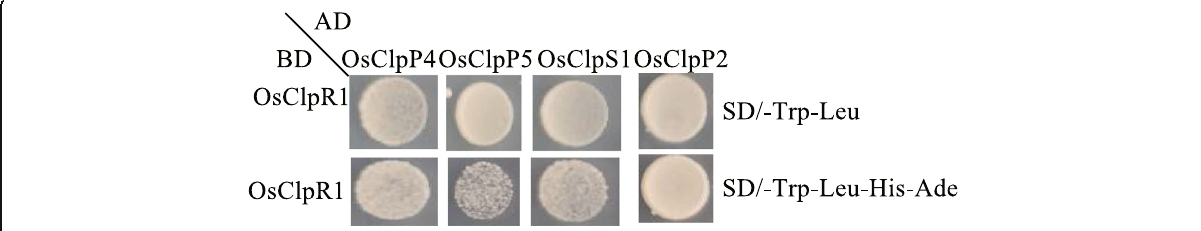
Fig. 7 Interaction between OsClpR1 and OsClpP4, OsClpP5, OsClpP2, and OsClpS1 by the yeast two-hybrid analysis. OsClpR1 was fused to the pGBKT7 vector (OsClpR1-BD). OsClpP4 , OsClpP5 , OsClpP2 , and OsClpS1 were fused to the pGADT7